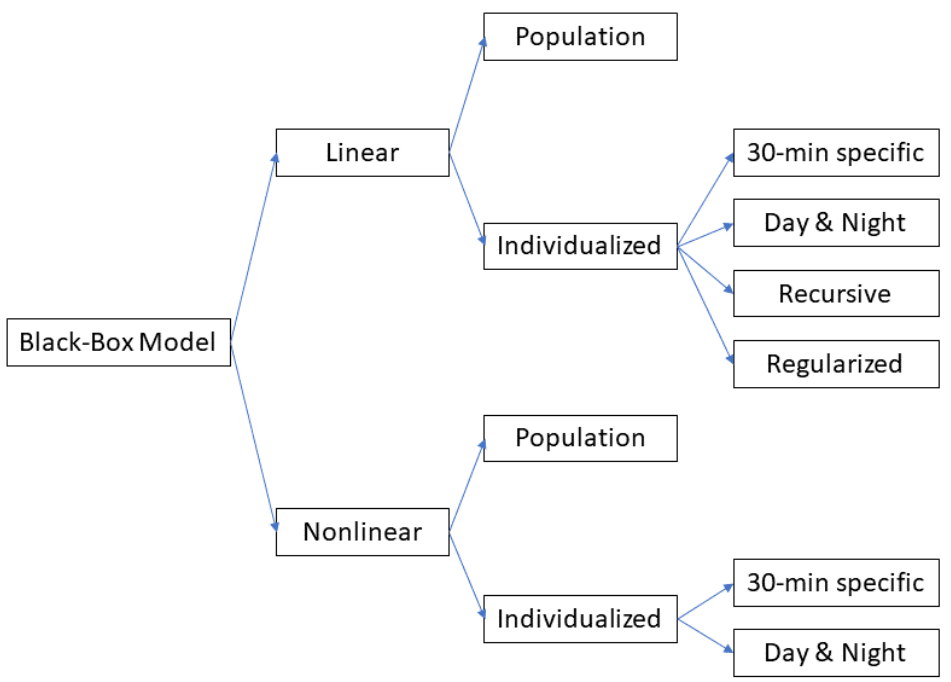
Figure 1. Schematic diagram of all the possibilities presented in this